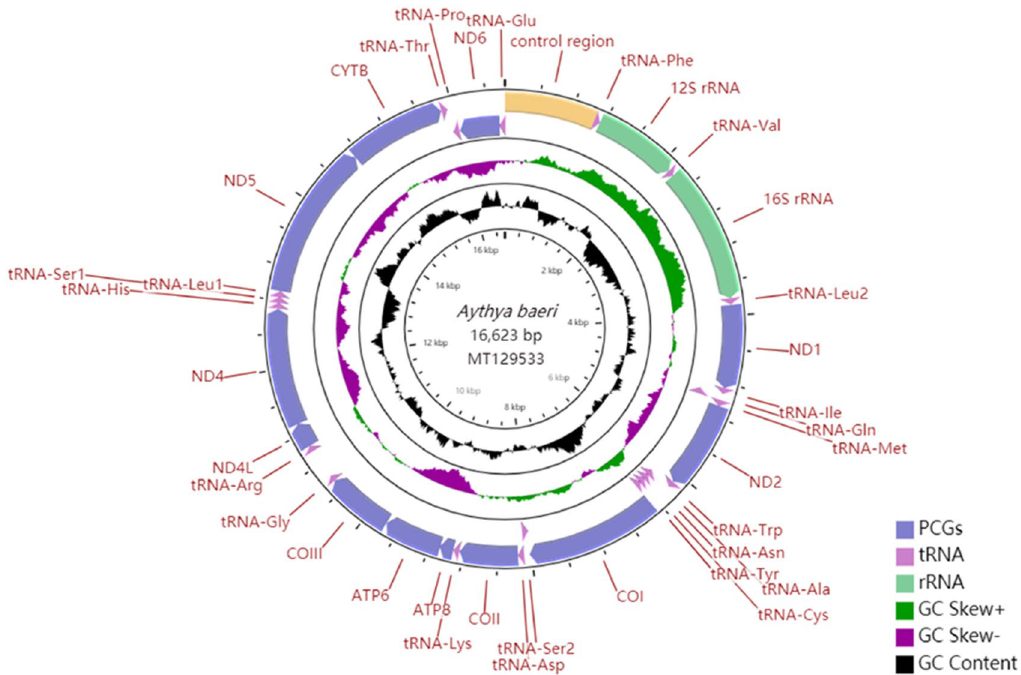
Figure 1. Circular map of the Aythya baeri mitochondrial genome. Different types of genes are indicated by squares of various colours. Genes encoded on the heavy or light strand are displayed on the outer or inner side of the circle, severally. The GC content of the mitogenome is represented by the black inner